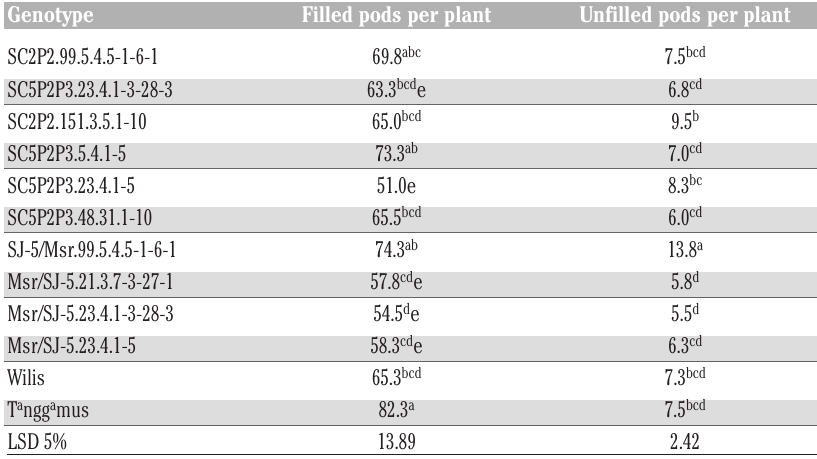
Table 3. Number of filled pods per plant and number of unfilled pods per plant of acid- adaptive soybean promising lines in Central Lampung, Indonesia. Genotype Filled pods per